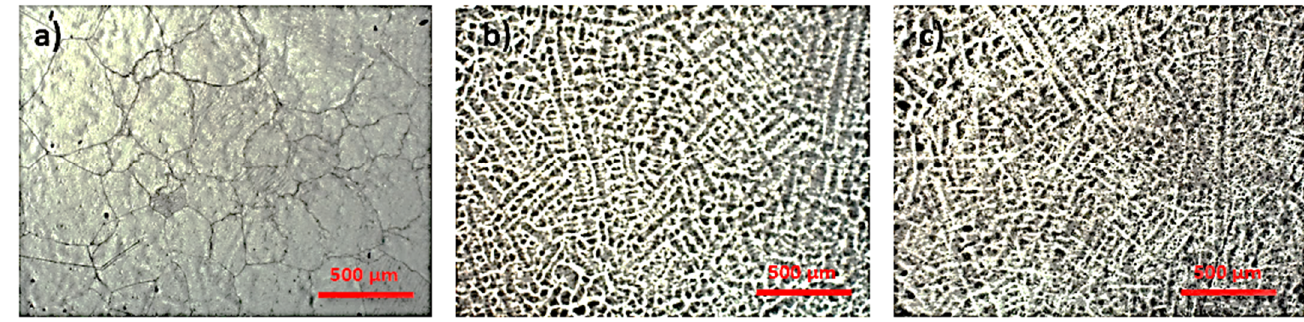
Figure 1. Optical microscopy images: ( a ) Ti20Mo7Zr5Ta, ( b ) Ti20Mo7Zr10Ta, ( c ) Ti20Mo7Zr15Ta.